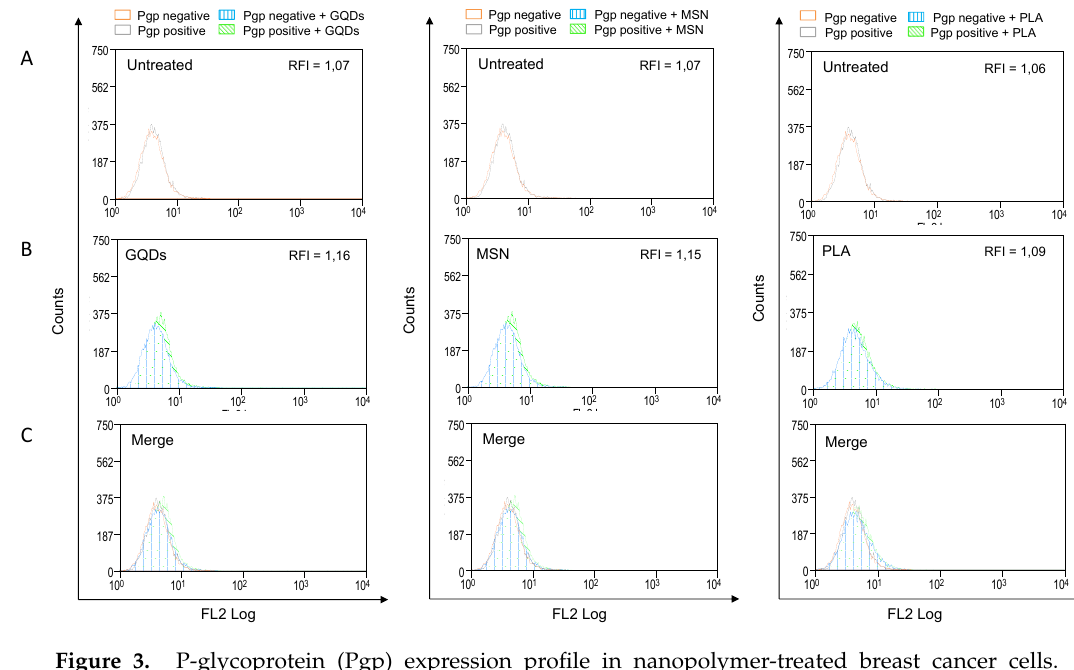
Figure 3. P-glycoprotein (Pgp) expression profile in nanopolymer-treated breast cancer cells. MDA-MB-231 cells were treated with 50 µ M graphene quantum dots (GQDs), mesoporous silica nanoparticles (MSN) or polymeric lactic acid (PLA) for 72 h and had P-gp expression compared with untreated cells ( A , B ). Cells were stained with PE-conjugated Pgp monoclonal antibody (UIC2, Coulter, USA) and evaluated by flow cytometry. For better visualization of di ff erences between untreated and nanopolymer-treated cells, histograms were merged ( C ). The results were expressed by Relative Fluorescence Intensity (RFI), calculated by the ratio between the fluorescence intensity in cells treated with UIC2 and the fluorescence intensity in